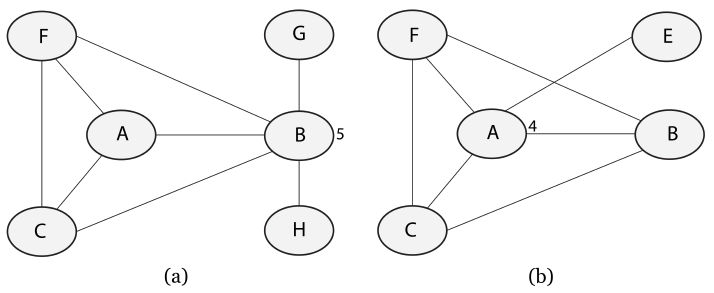
Figure 3. Neighborhood graphs in a social network: ( a ) Graph for Bob, ( b ) graph for